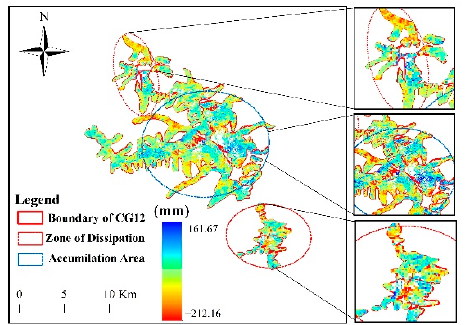
Figure 14. Statistics of glacier deformation zoning in the Meili Snow Mountain.